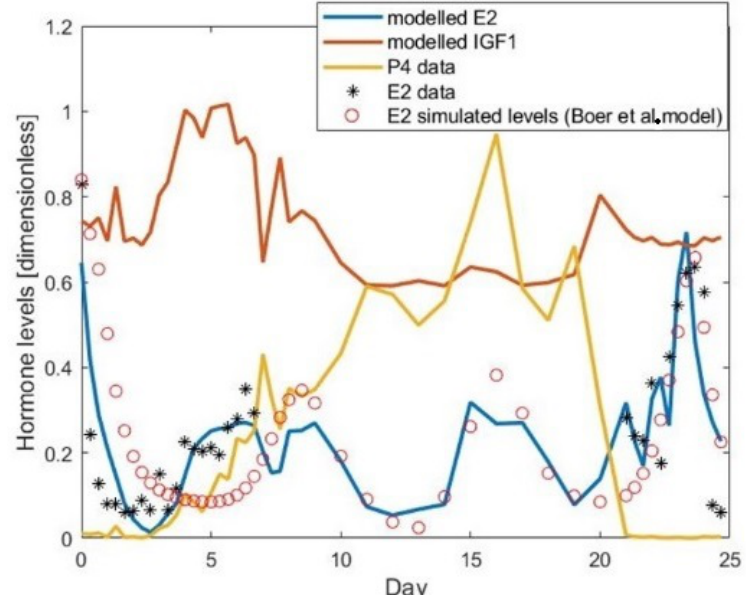
Figure 1. Chosen hormones during the estrous cycle.